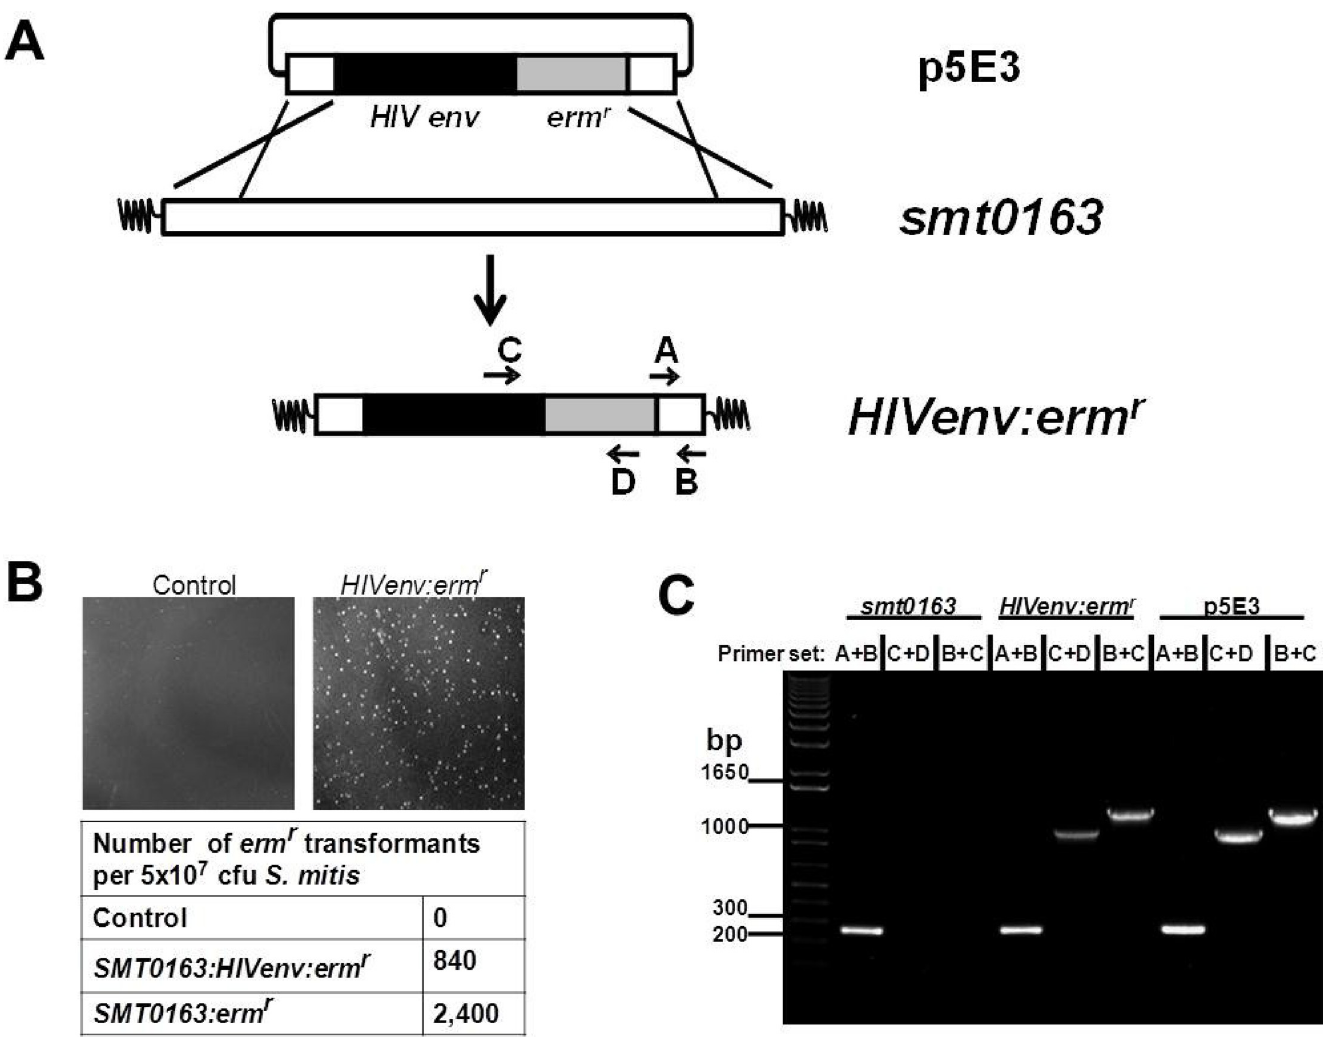
Fig 1. Construction of recombinant S . mitis expressing HIV Env gp120. (A) Recombinant S . mitis ( rS . mitis ) was generated by homologous recombination. The p5E3 suicide plasmid was created by inserting the S . mitis codon-optimized HIV-1 HXBc2 Env gp120-His-tag (HIV Env) in-frame with the 250bp 5 ’ end of the pullulanase gene (pulA/Smt0163) followed by ermr gene and the 250bp 3 ’ end of the pulA gene into pCR2.1 for transformation and integration into the Smt0163 locus. (B) S . mitis was transformed with water (control), p5E3 ( Smt0163 : HIVenv : erm r ) or pCR2.1 containing ermr flanked by 250bp pulA 5 ’ and 3 ’ fragments ( Smt0163 : erm r ). Growth of transformants on THB plates containing 50 μ g/ml erythromycin and transformation frequency are shown. (C) Integration was confirmed by PCR using S . mitis -specific primers A/B, HIV-specific primer C and ermr-specific primer D.